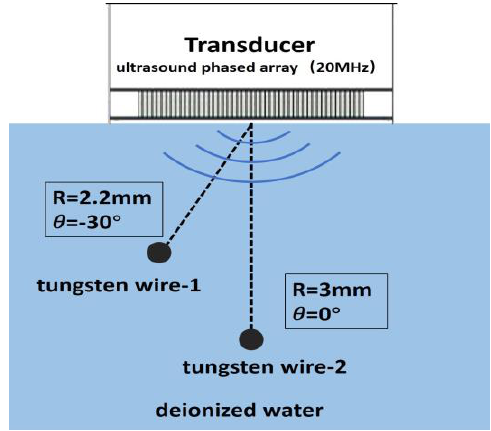
Figure 8. Schematic diagram of tungsten wire phantom in deionized water.